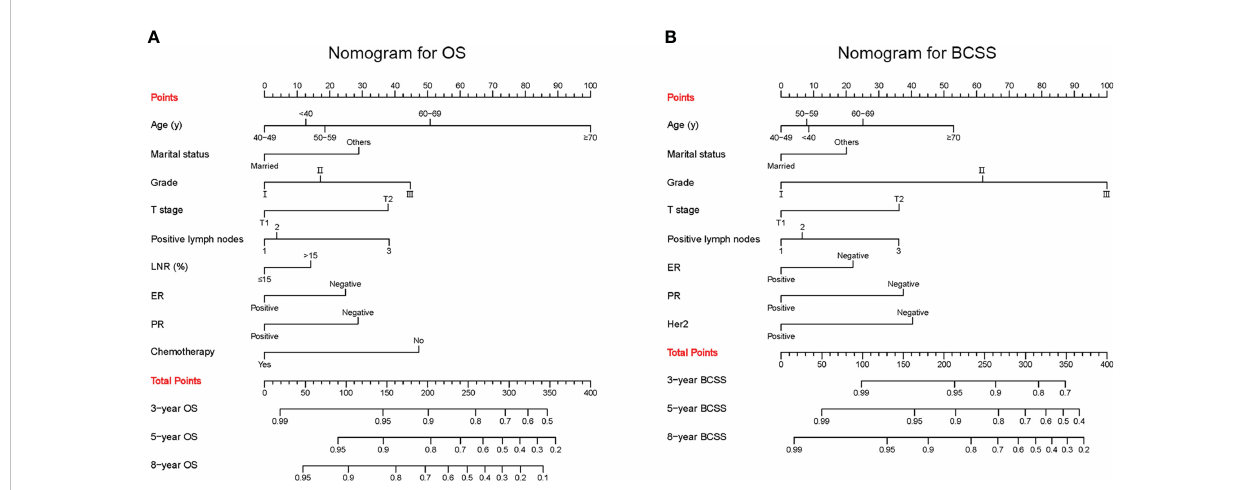
FIGURE 3 Predictive nomograms. (A) Nomogram for predicting 3-, 5- and 8-year OS. (B) Nomogram for predicting 3-, 5- and 8-year BCSS. LNR, lymph node ratio; ER, estrogen receptor; PR, progesterone receptor; Her2, Human epidermal growth factor receptor 2; OS, overall survival; BCSS, breast cancer- speci fi c